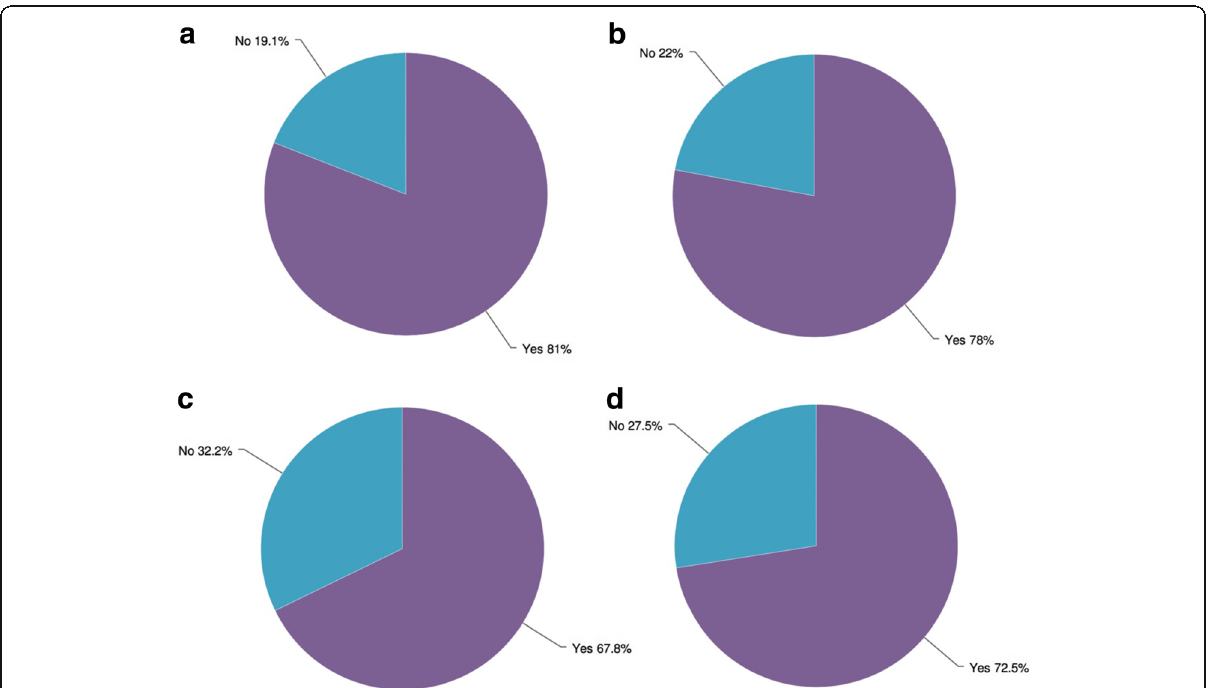
Fig. 2 Clinical practice highlights from respondents. a Perform peripheral vascular disease interventions. b Availability of dedicated IR nursing staff. c Have IR trainees. d Participate in 24/7 IR